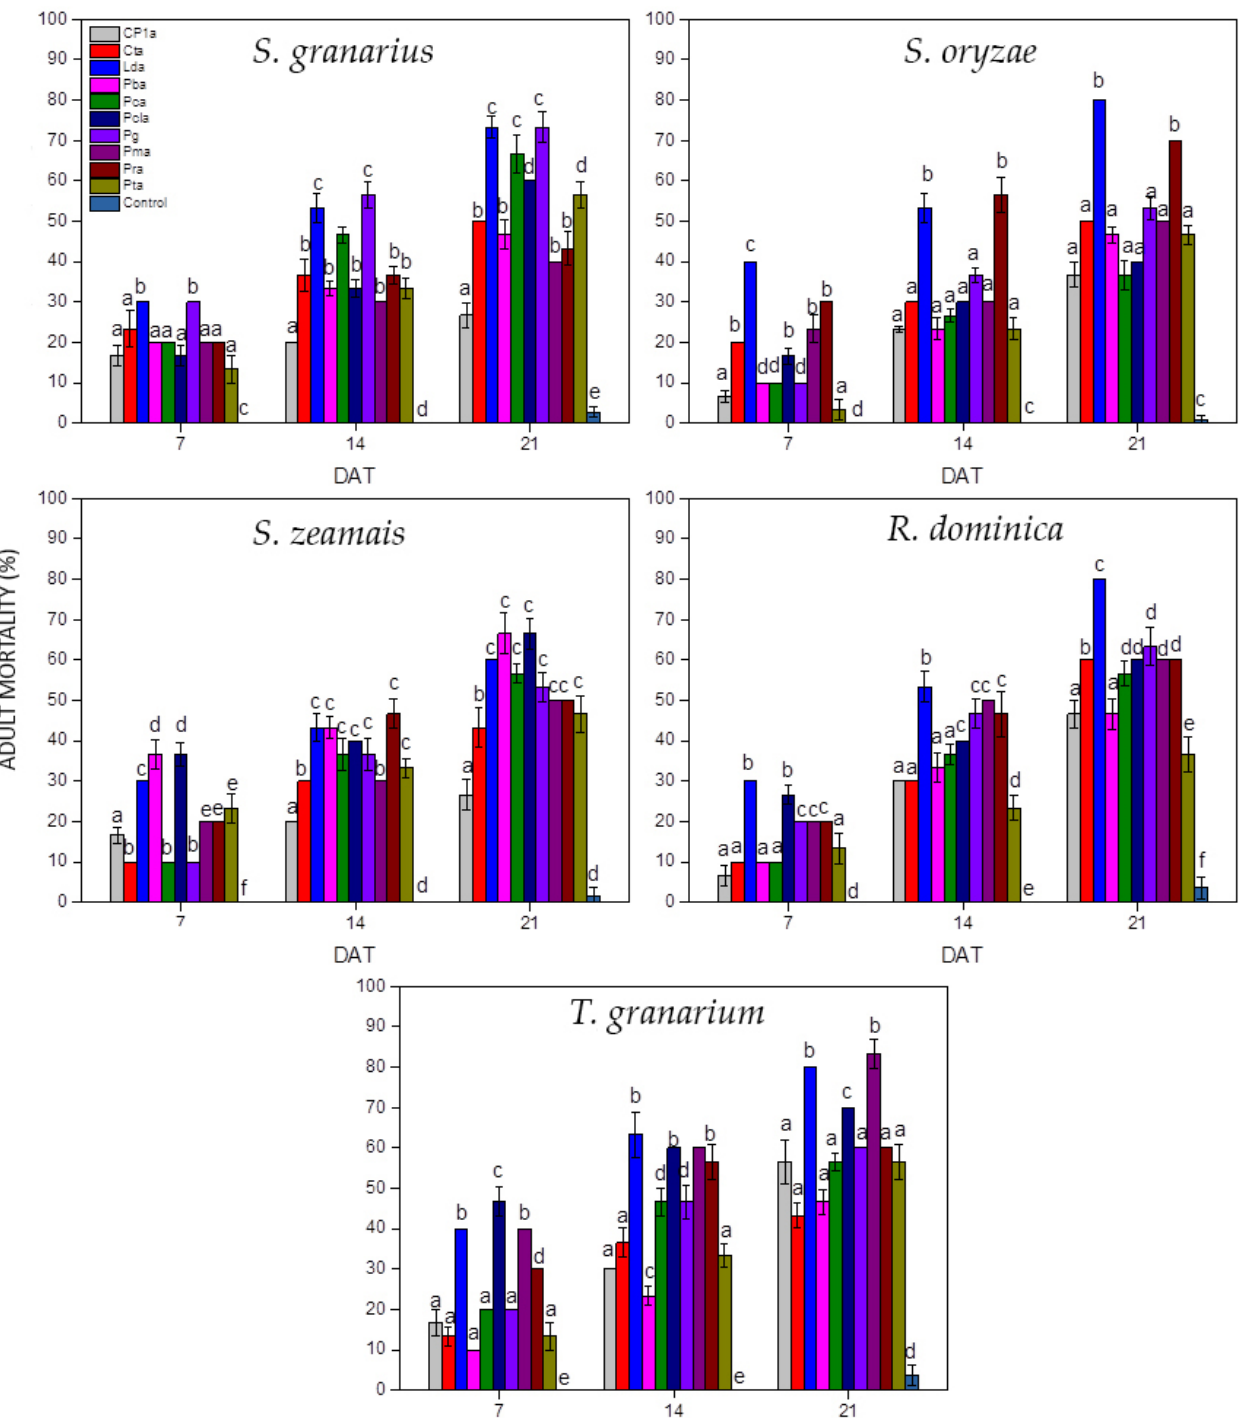
Figure 1. Mean mortalities (%) of experimental adult beetles treated with EPF in the present study (grains were sprayed with conidial suspension at 10 8 conidia/mL DAT: days after treatment, columns of the same DAT marked with the same letter did not differ significantly, error bars represent standard deviation of the mean).